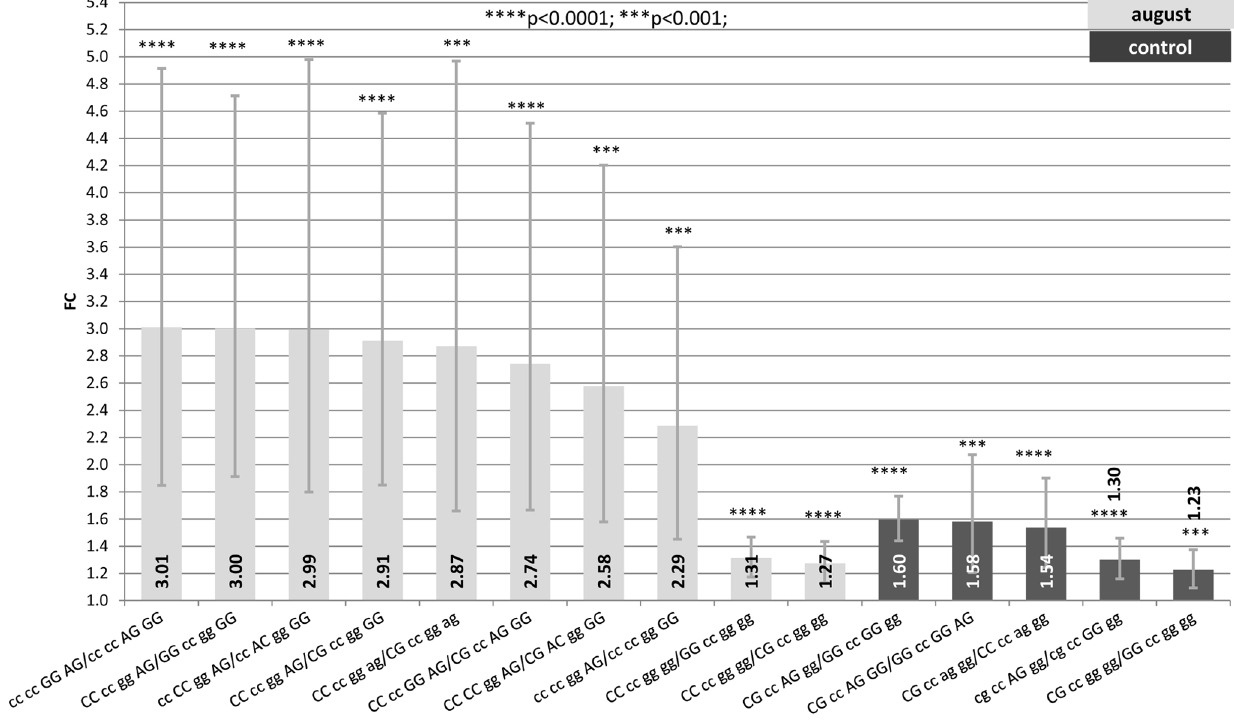
Figure 1. Fold change (FC) for the contrast among alternative genotypes G/C 2 660 -C/A 2 601 -G/A 2 522 -A/G 2 444 of the HSP90AA1 promoter within each treatment (Control, July and August) normalized by HSP90AB1 . Segments indicate the 95% confidence interval (FC up -FC low ). In abscissa the FC, in ordinate genotype contrasts. Asterisk over each bar indicates the significance level of the contrasts. doi:10.1371/journal.pone.0066641.g001 PLOS ONE |